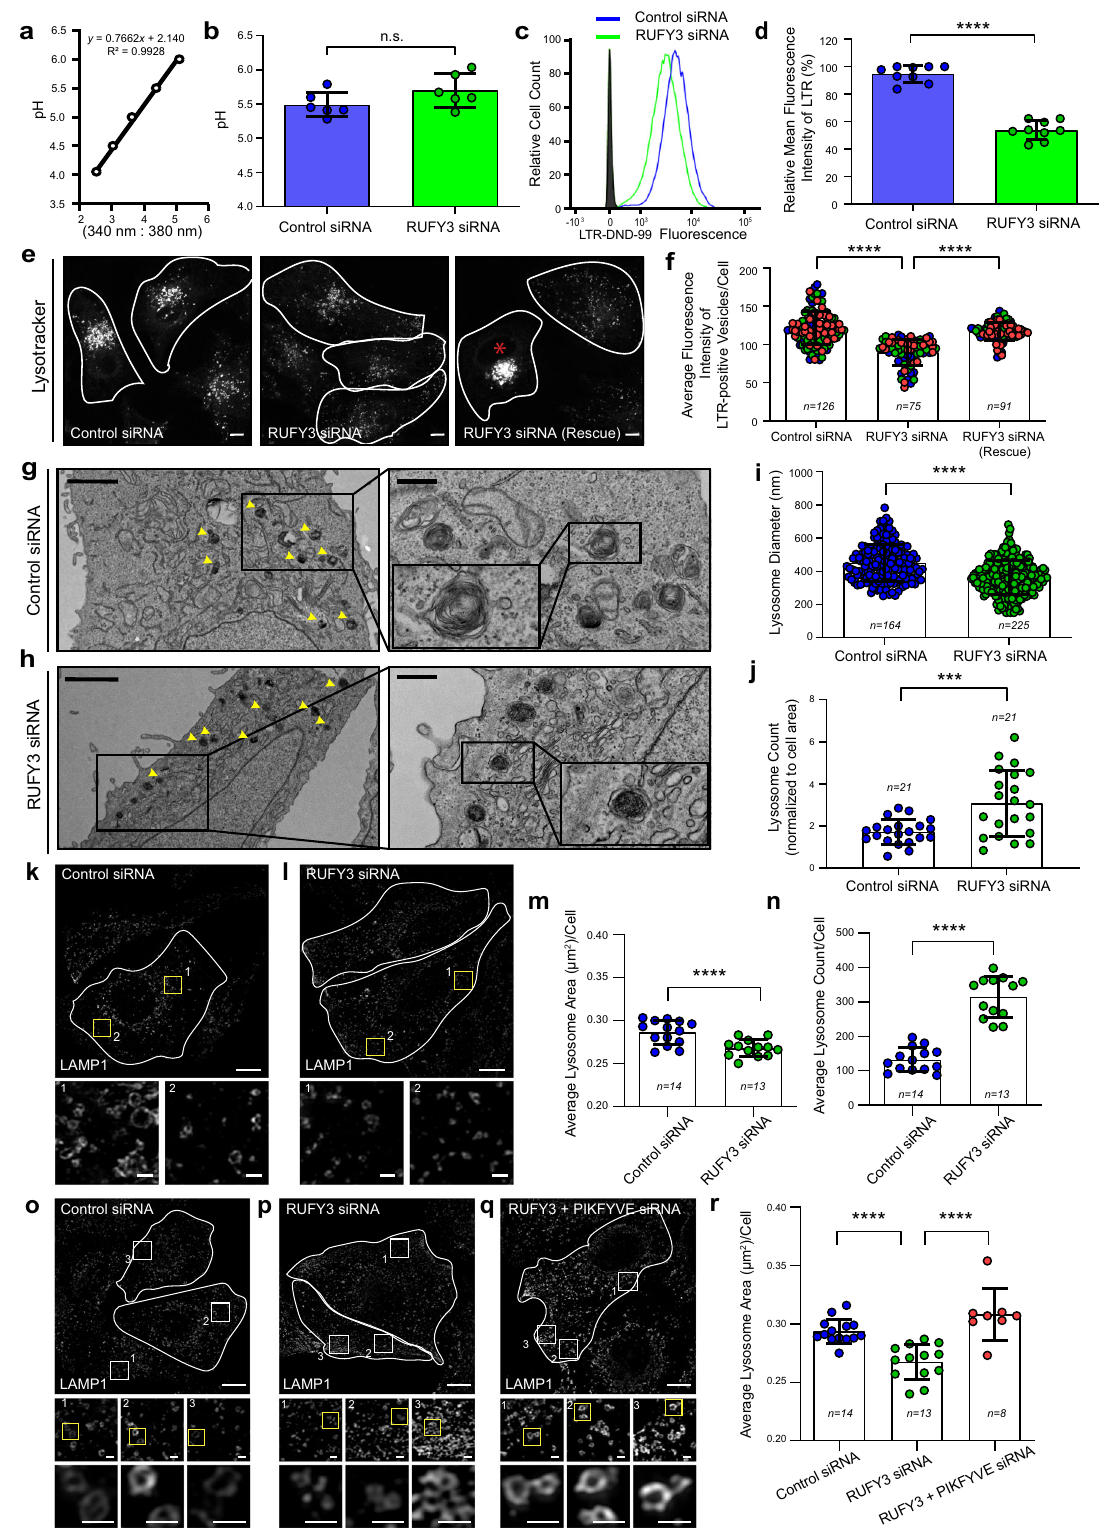
Structured illumination microscopy (SIM) . For SIM imaging, cells were pro- cessed, fi xed, and stained as described previously. SIM images were captured with Zeiss ELYRA 7 (Lattice SIM Technology) using either Plan Apo 40×/1.40 oil or Plan Apo 63×/1.40 oil objective and sCMOS camera (PCO Edge). A lattice pattern structured samples and 15 phases shifted raw images were acquired for every Z plane with a slice size of 110 nm. The complete system control, imaging